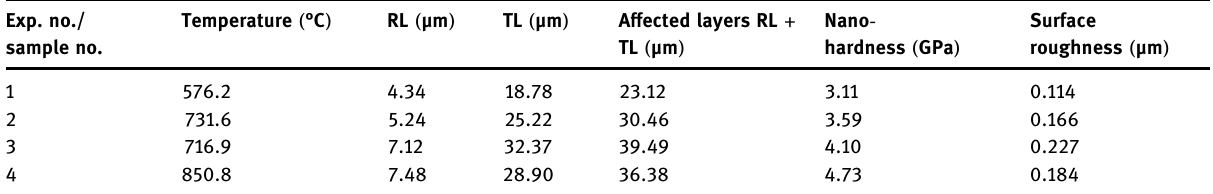
Table 6: FEM simulation data for predicted cutting temperature, measured depth of the a ff ected layers, nano - hardness, and surface roughness after machining at various machining parameters Exp. no./